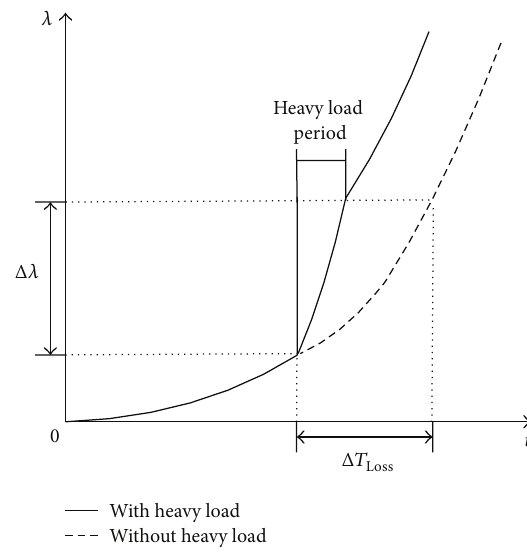
Figure 2: The impact of the heavy load on the insulation failure rate of